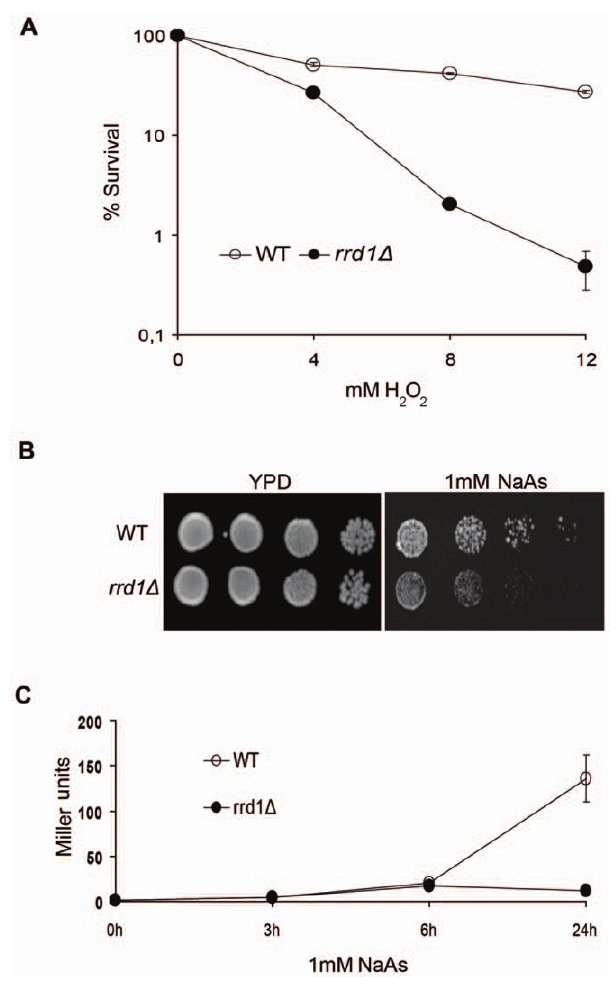
Figure 6. rrd1 D mutants display hypersensitivity to agents causing oxidative stress. ( A ) Survival curve of WT (open circle) and rrd1 D mutant strains (closed circle) upon H 2 O 2 treatment. H 2 O 2 concentrations are indicated below; result shown is an average of three independent experiments and error bars indicate the standard deviation. ( B ) Spot test analysis of WT and rrd1 D mutant strain on YPD agar plates, containing 1 mM sodium arsenite (NaAs), where indicated. ( C ) LacZ reporter expression analysis from the ACR3 promoter-lacZ fusion plasmid, expressed in Miller units. WT (open circle) and rrd1 D mutant (closed circle) show the lacZ expression over time in response to 1 mM NaAs treatment ( n =5).